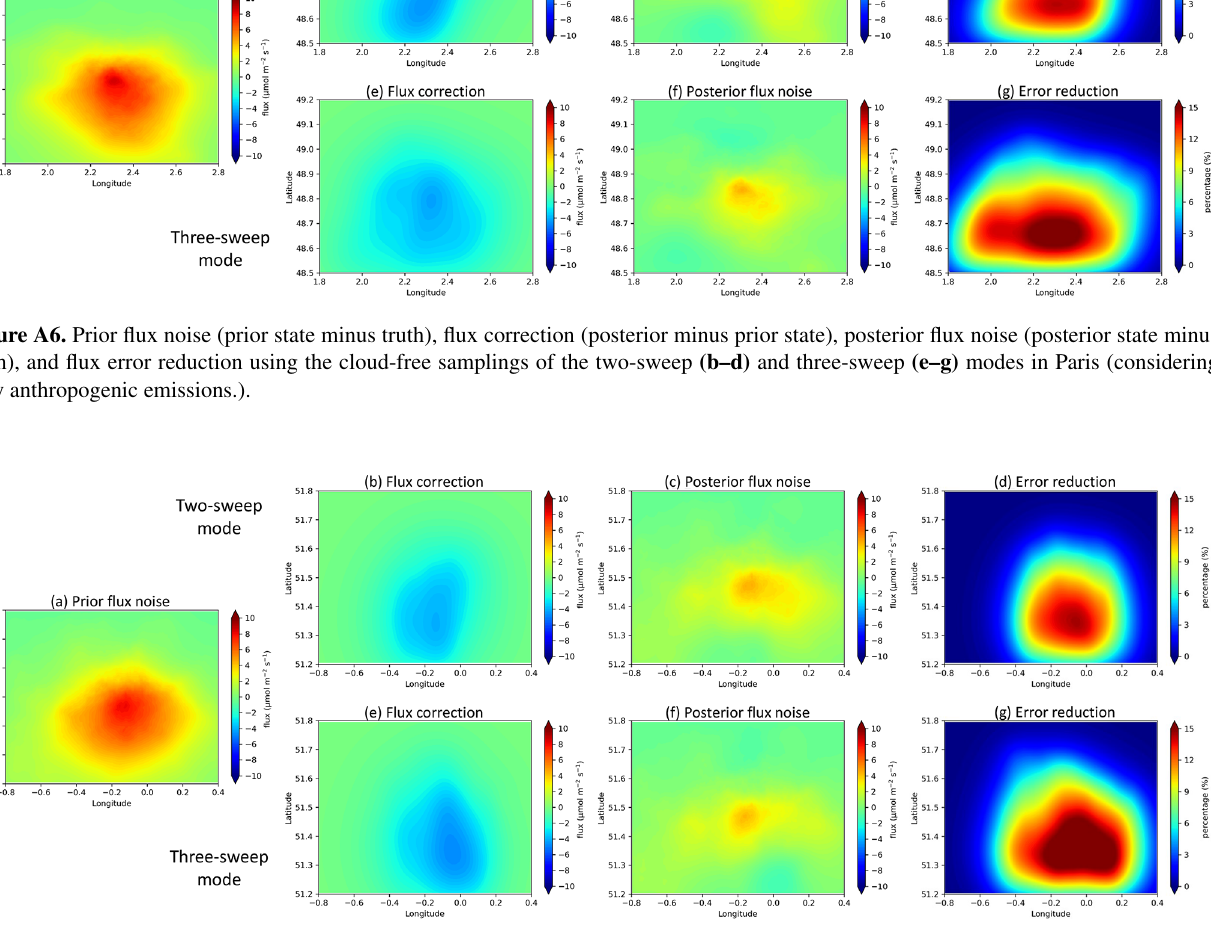
Figure A7. Same as Fig. A6 but for